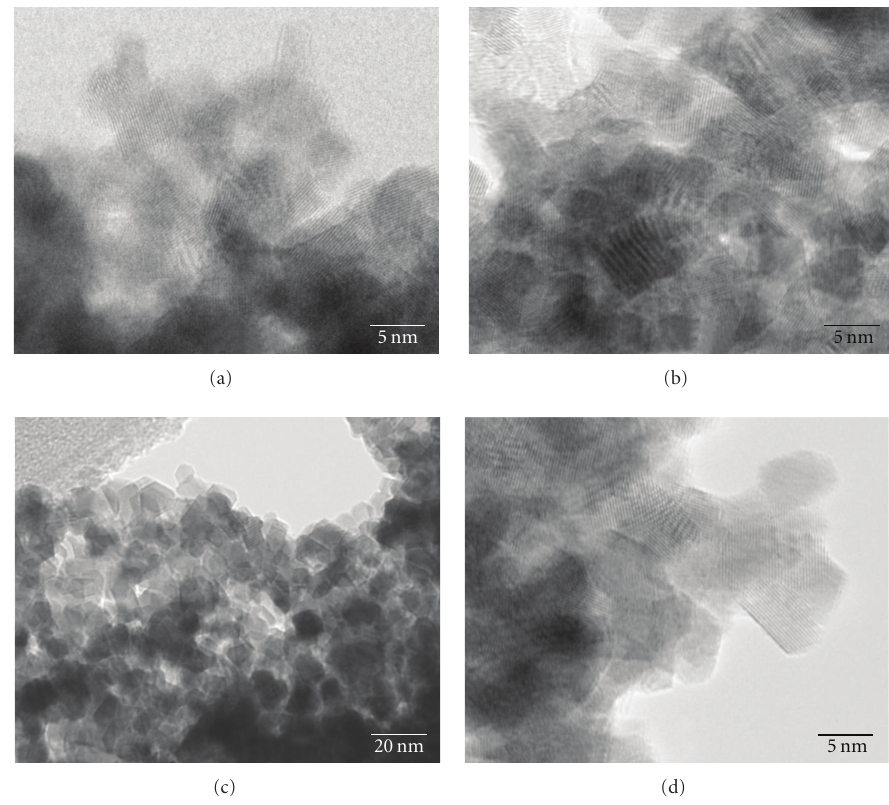
Figure 2: TEM images of the as-prepared trimetallic catalysts: (a) RPR333, (b) RPR322, (c) RPR232, and (d) RPR223.